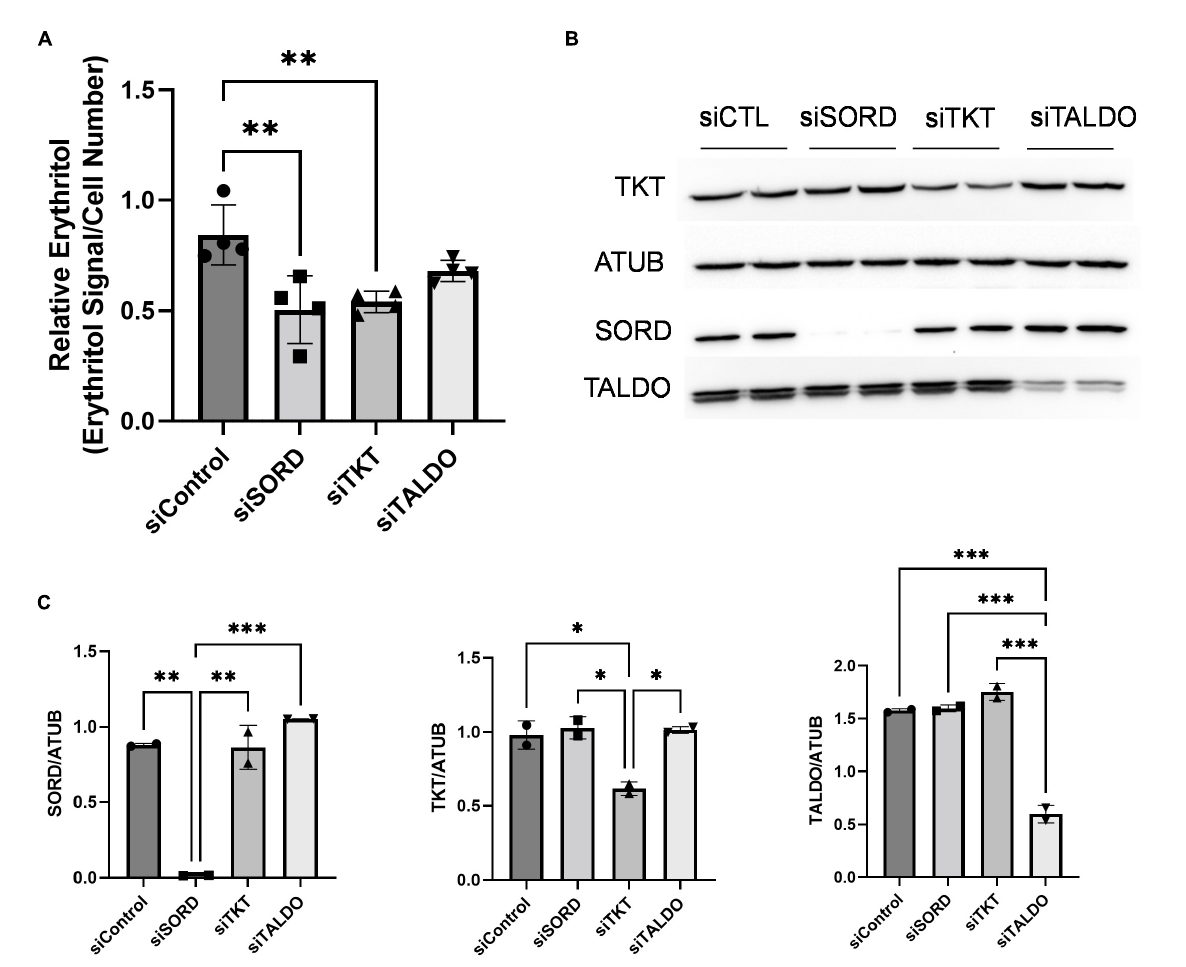
FIGURE4 Knockdown of non-oxidative PPP enzymes SORD and TKT decrease intracellular erythritol levels. Knockdown of SORD, TKT, and TALDO were performed using reverse transfection. After 48 h treatment with 25 mM glucose media, (A) intracellular erythritol ( n = 4) and (B) protein expression was measured. (C) Protein expression was quantified using Image J ( n = 2). Relative erythritol is normalized to internal standard and cell number. Data is shown as mean ± SD and was analyzed by ordinary one-way ANOVA and Tukey’s multiple comparisons test. ∗ p < 0.05, ∗∗ p < 0.01, ∗∗∗ p < 0.001. ATUB, alpha tubulin; CTL, control; SORD, sorbitol dehydrogenase; TALDO, transaldolase; TKT,